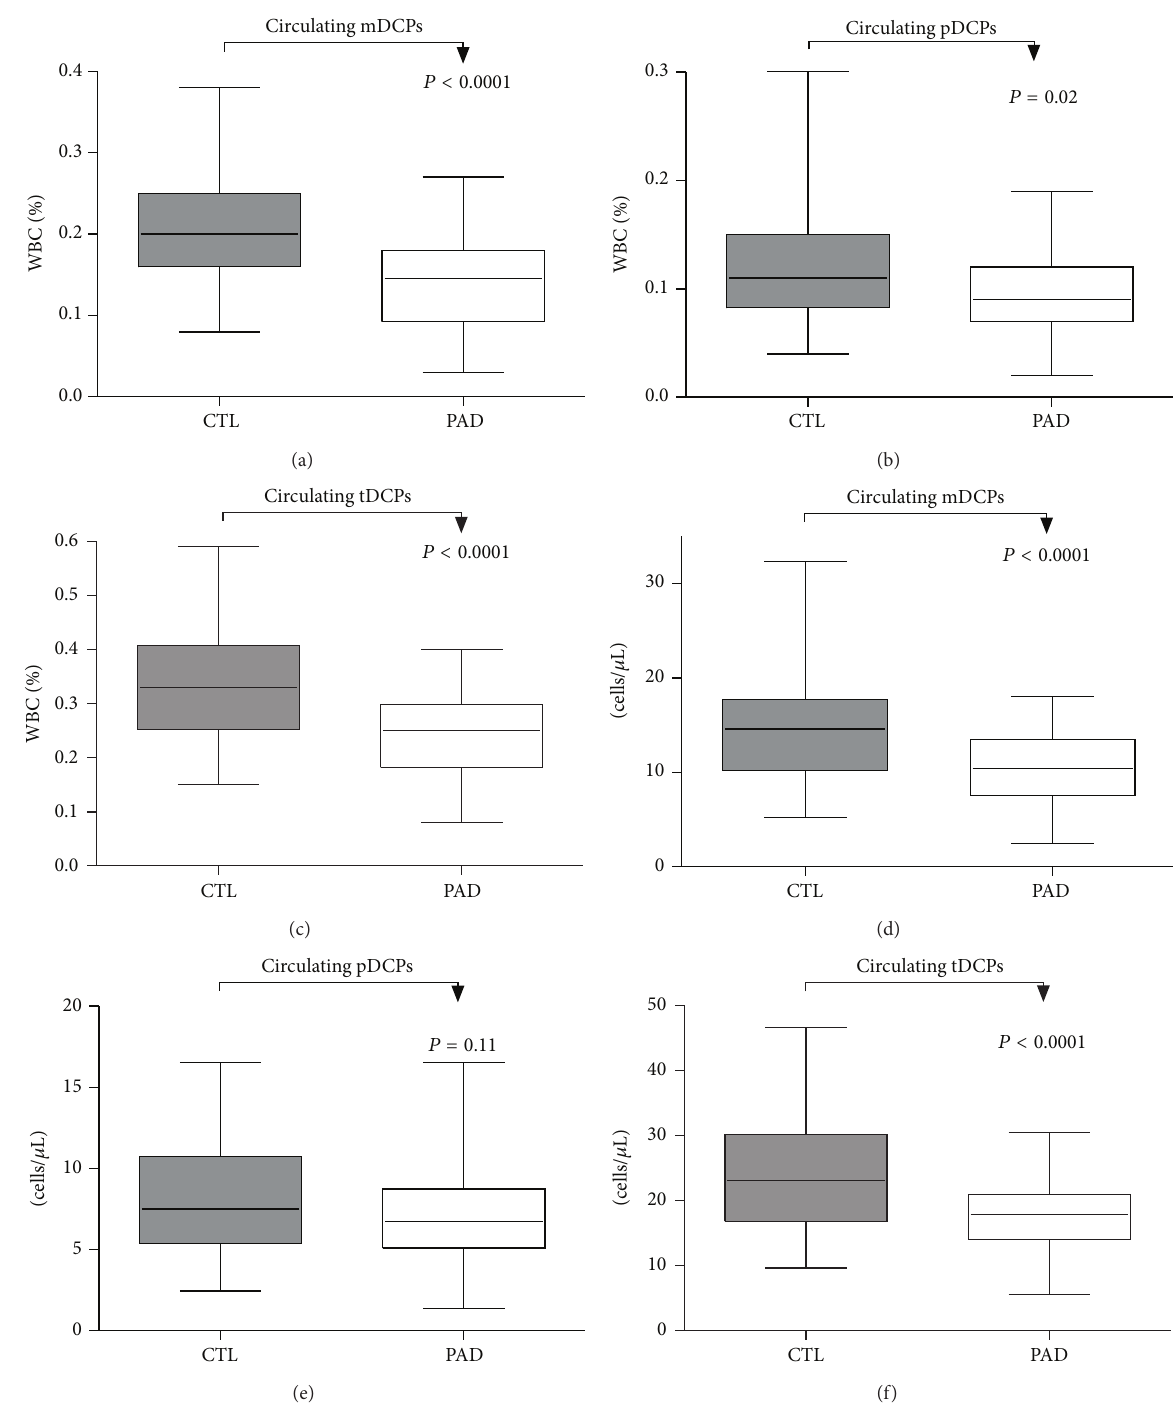
Figure 2: Frequency of circulating mDCPs, pDCPs, and tDCPs in patients with PAD compared with healthy controls. Relative numbers of circulating mDCPs (a), pDCPs (b), and tDCPs (c) shown as percentage of white blood cell count (% of WBCs) and absolute numbers of circulating mDCPs (d), pDCPs (e), and tDCPs (f) (cells/ 𝜇 L) are shown. The box plots indicate the median (line inside the box), 25th and 75th percentile (lower and upper boundary of the box), and 10th and 90th percentile (whiskers outside